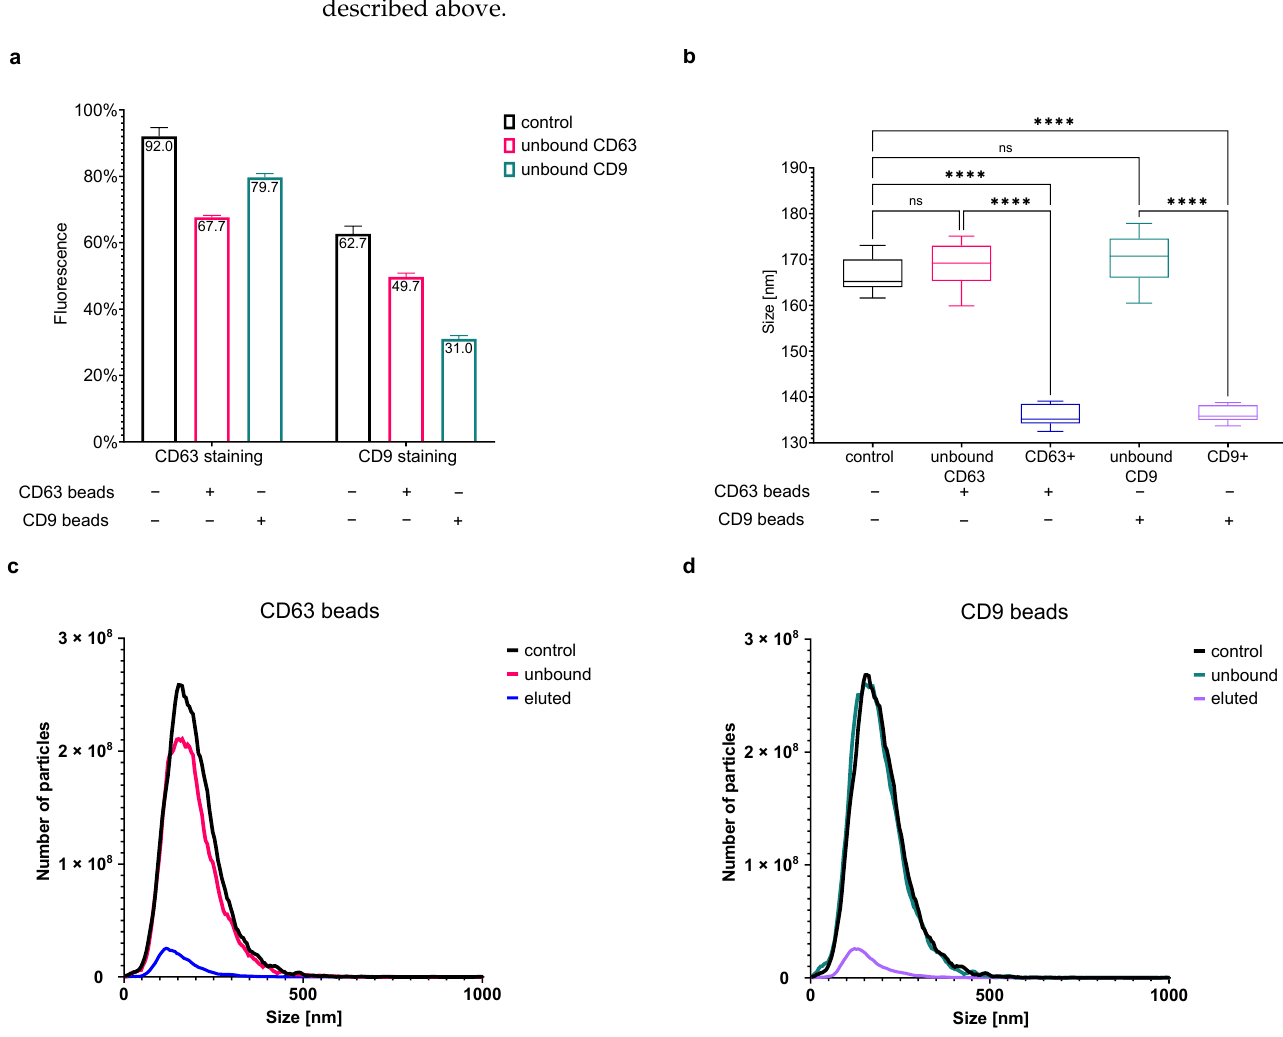
Figure 8. Depletion of EV-subpopulations by immune-magnetic bead separation. ( a ) The percent of fluorescent particles in comparison to all particles visible in scatter mode for oBALF-EVs of one patient. The first three bars represent the percentage CD63 positive particles, and bars 4–6 represent the percentage of CD9 positive particles relative to particles in scatter. ( b ) Measured mode sizes of particles in scatter mode of oBALF-EVs of one patient. ( c , d ) Distribution of number and size of detected particles in scatter mode of oBALF-EVs of one patient for the CD63 beads ( c ) and CD9 beads ( d ) experiment. For graphs ( a – d ), the colors stand for the following sample types: control sample (black), fraction unbound to CD63 beads (pink), fraction eluted from CD63 beads (blue), fraction unbound to CD9 beads (green), and fraction eluted from CD9 beads (violet). Graph ( a ) presents the mean and SD from three repetitions. Graph ( b ) presents the mean and SD from twelve repetitions. Graphs ( c , d ) present the mean from three repetitions. **** refers to p value ≤ 0.0001, ns refers to p value > 0.05, from t -test-paired